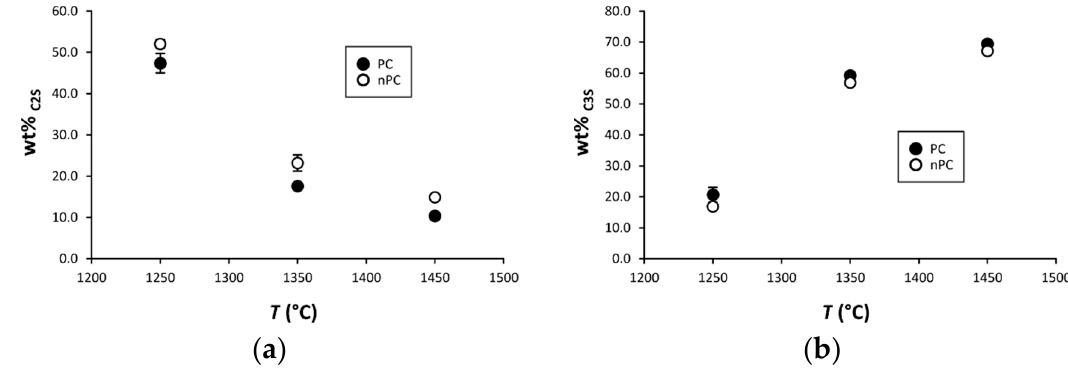
Figure 11. Binary plots ( a ) C2S vs. T and ( b ) C3S vs. T for PC (filled symbols) and nPC (empty symbols) at the three burning temperatures. If not present, error bars in wt % are within the symbols.